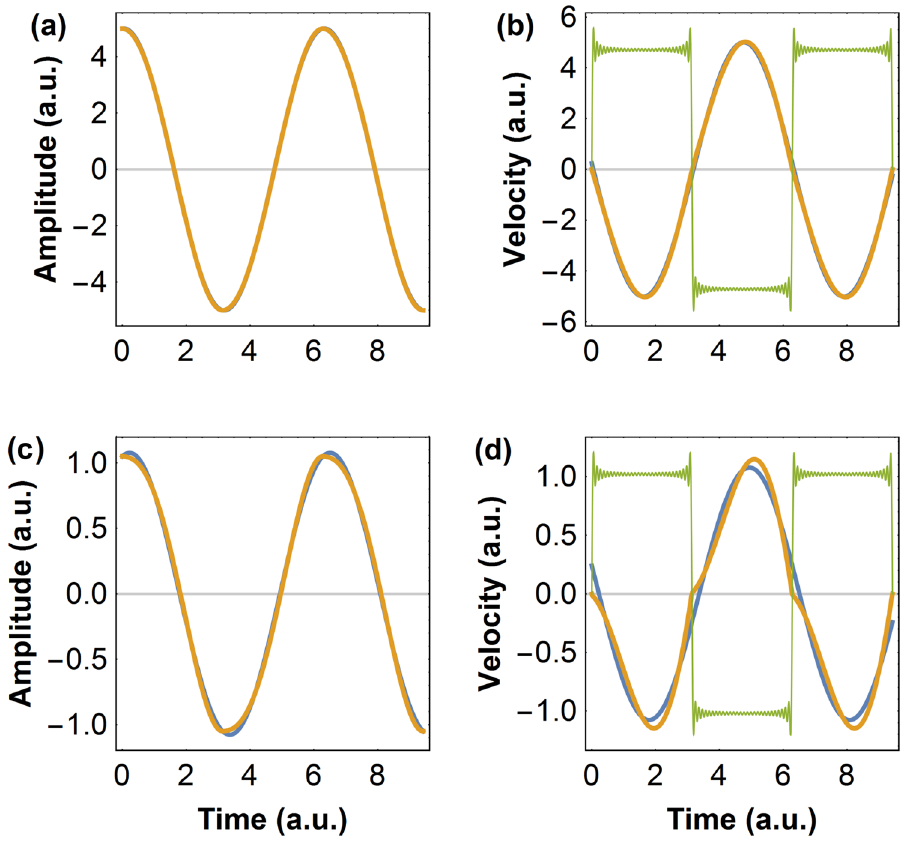
Figure 1. Oscillator amplitude ( a ) and velocity ( b ) versus time for a system submitted to a friction such that the oscillator gain is G = 5, showing the leading (blue) and the first 30 terms of the Fourier series (orange); in ( a ) the two curves are indistinguishable, in ( b ) we additionally plot the friction force (green), rescaled for clarity; ( c , d ) the same as in ( a , b ) for a higher friction force such that G =